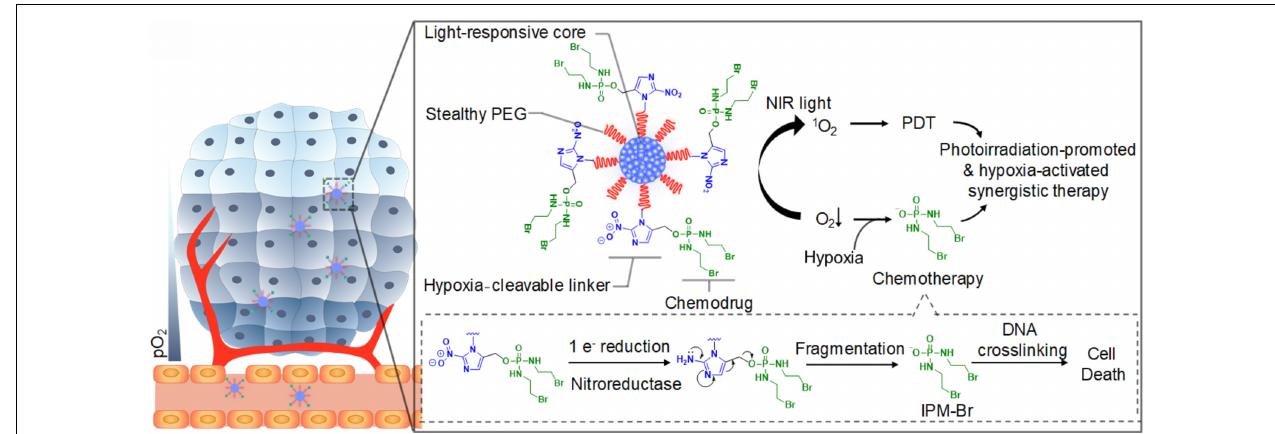
FIGURE 7 | Schematic illustration of the light-responsive SPNpd for synergistic cancer therapy. The nano-prodrug is assembled from an amphiphilic semiconducting brush polymer grafted with chemo drug side chains through a hypoxia-cleavable linker. It has three critical units: the light-responsive photodynamic SPN core, hypoxia-cleavable linker and the chemotherapeutic drug, a bromoisophosphoramide mustard intermediate (IPM-Br). Upon the photoirradiation at 808 nm, this organic photodynamic nano-prodrug (SPNpd) can specifically release the chemodrug under photoirradiation-promoted hypoxia tumor microenvironment to exert synergetic PDT and chemotherapy. Reprinted from Dong Cui, Jiaguo Huang, Xu Zhen, et al. Semiconducting Polymer Nano-prodrug for Hypoxia-activated Synergetic Photodynamic Cancer therapy. Angew Chem Int Ed Engl 2019;58(18):5920–24. With permission from reference (Cui et al., 2019). SPNpd, semiconducting polymer nanoprodrug; SPN, semiconducting polymer nanoparticle; PDT, photodynamic therapy.